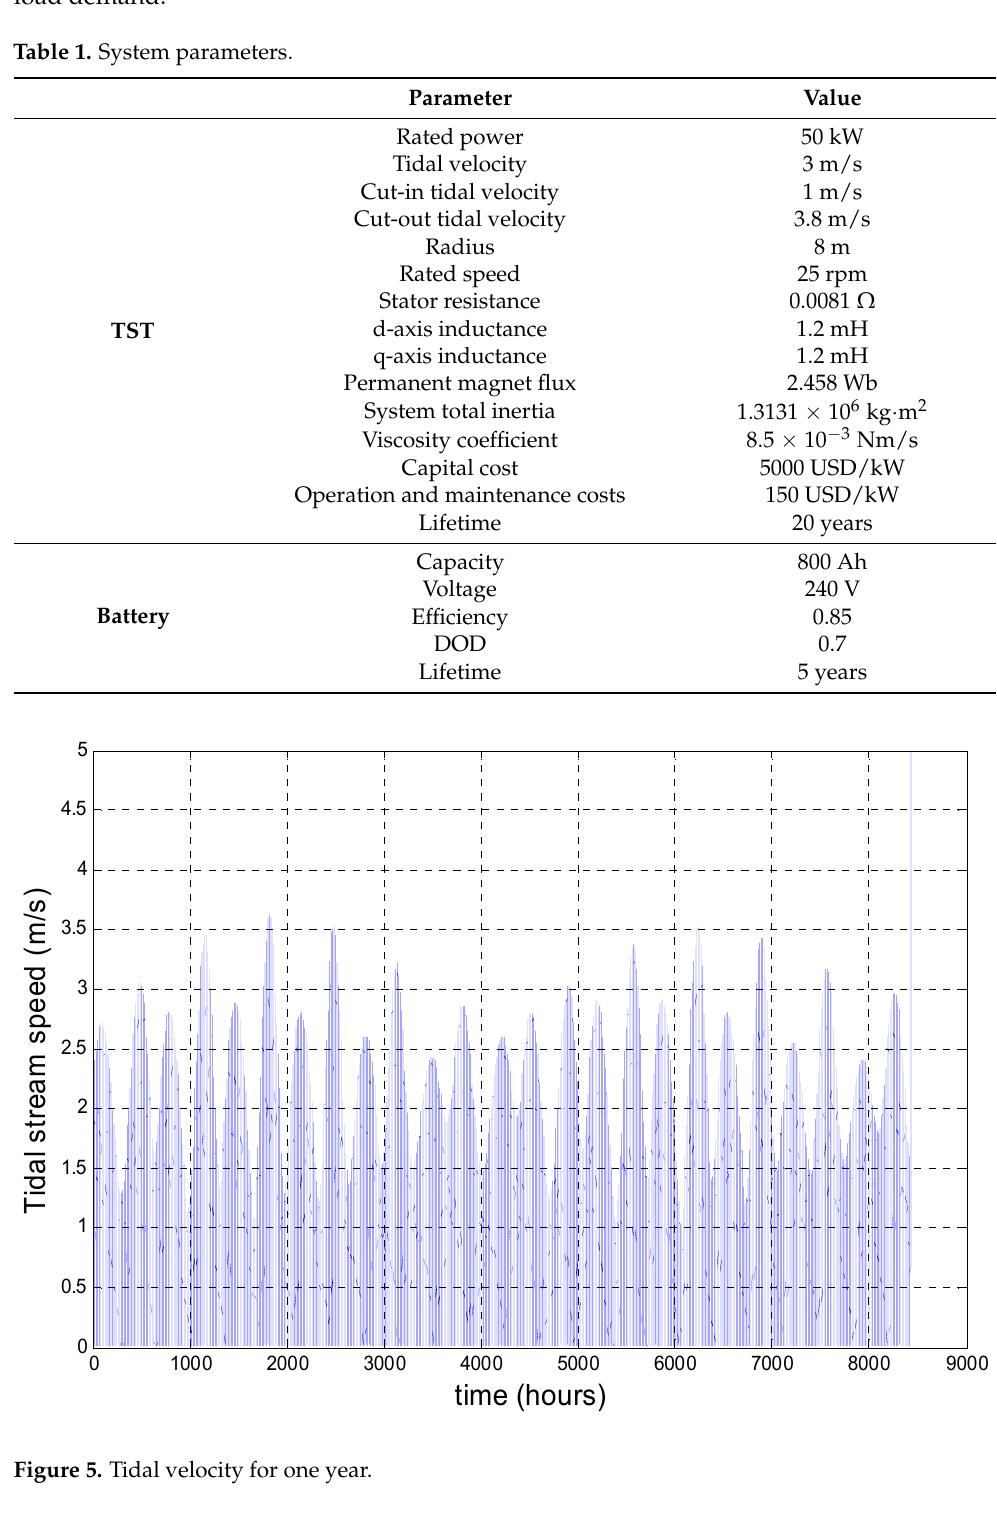
Table 1. System parameters.